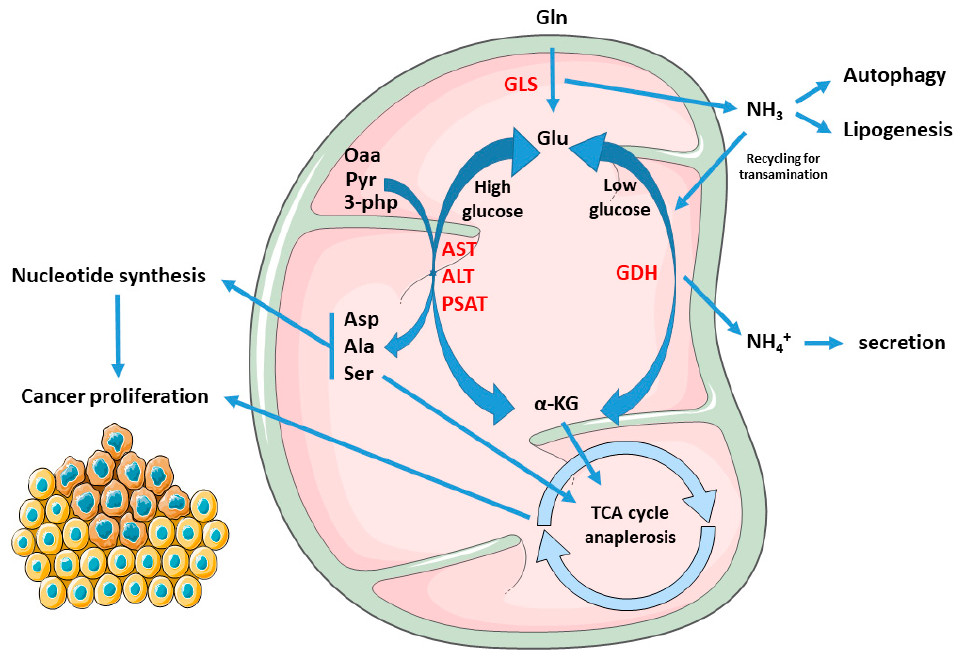
Figure 1. Rewiring of the metabolic fate of AAs in cancers: Gln- derived Glu yield α -kg through both transamination or dehydrogenation, by means of AST, ALT, PSAT, or GDH, respectively. The first pathway prevails in conditions of glucose abundance, resulting in production of the NEAAs Asp, Ala, and Ser, and enabling proliferation. Asp is used in nucleotide synthesis while α -kg, Ala, and Ser can feed the TCA cycle. On the other hand, GDH is activated during glucose scarcity or cell quiescence, supporting cell survival and stress resistance. Furthermore, GLS-derived ammonia in cancer can stimulate autophagy, lipogenesis, or being re-incorporated to Glu synthesis, which can be re-routed for transamination and biomass production. Abbreviations: Gln, glutamine; Glu, glutamate; Asp, aspartate; Ala, alanine; Ser, serine; GDH, glutamate dehydrogenase; GLS, glutaminase. AST, aspartate transaminase; ALT, alanine transaminase; PSAT, phosphoserine transaminase; Oaa, oxaloacetate; Pyr, pyruvate; 3-Php, 3-phosphohydroxypyruvate; α -KG, alpha- ketoglutarate.